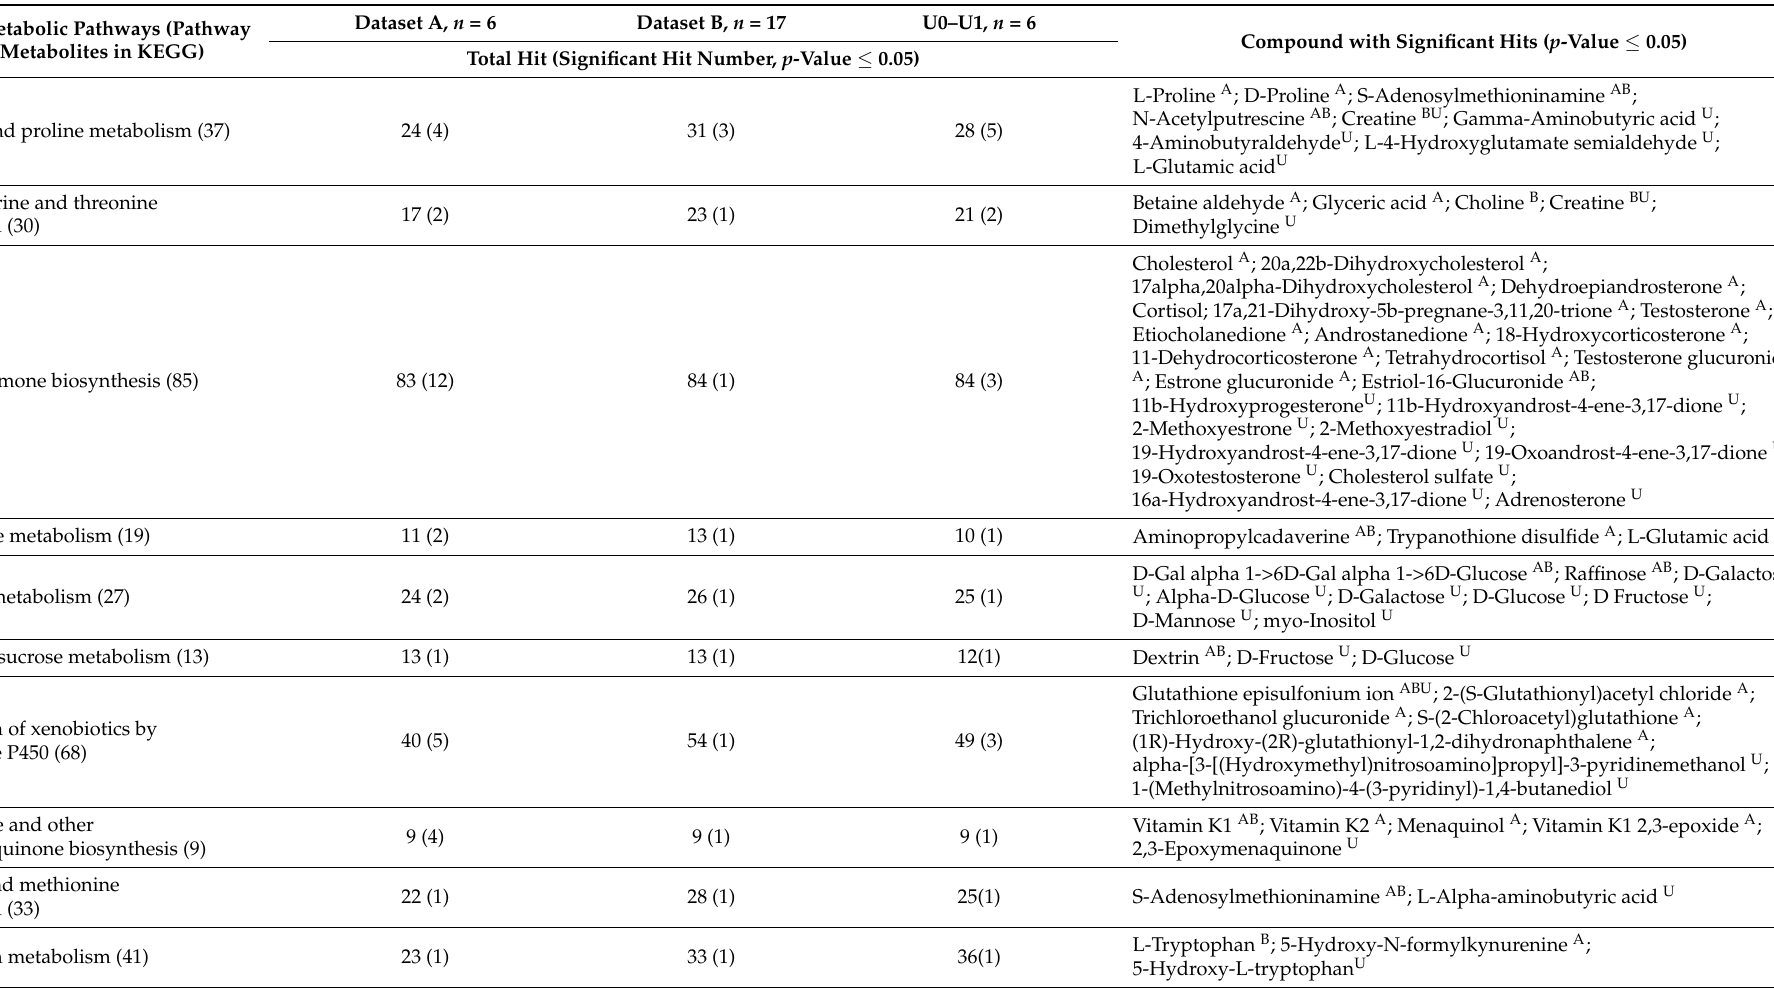
Table 4. The human metabolic pathways, total metabolite hits, significant metabolite hits for three datasets in positive mode and negative mode using pooling peaks with mummichog